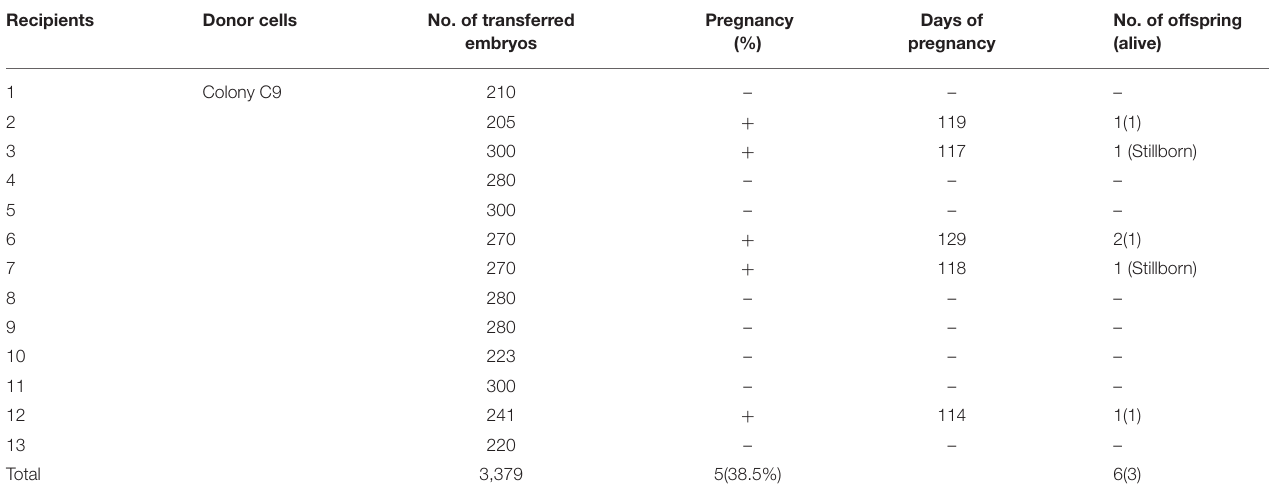
TABLE 1 | The embryo transfer and generation of GBC-modified piglets.